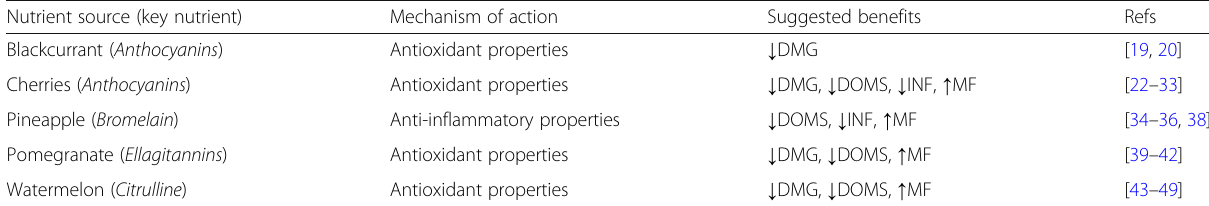
↓ DMG nutrient reduced indirect markers of muscle damage compared to placebo, ↓ DOMS nutrient reduced soreness and delayed-onset muscle soreness compared to placebo, INF nutrient reduced markers of inflammation compared to placebo, ↑ MF nutrient improved muscle function relative to